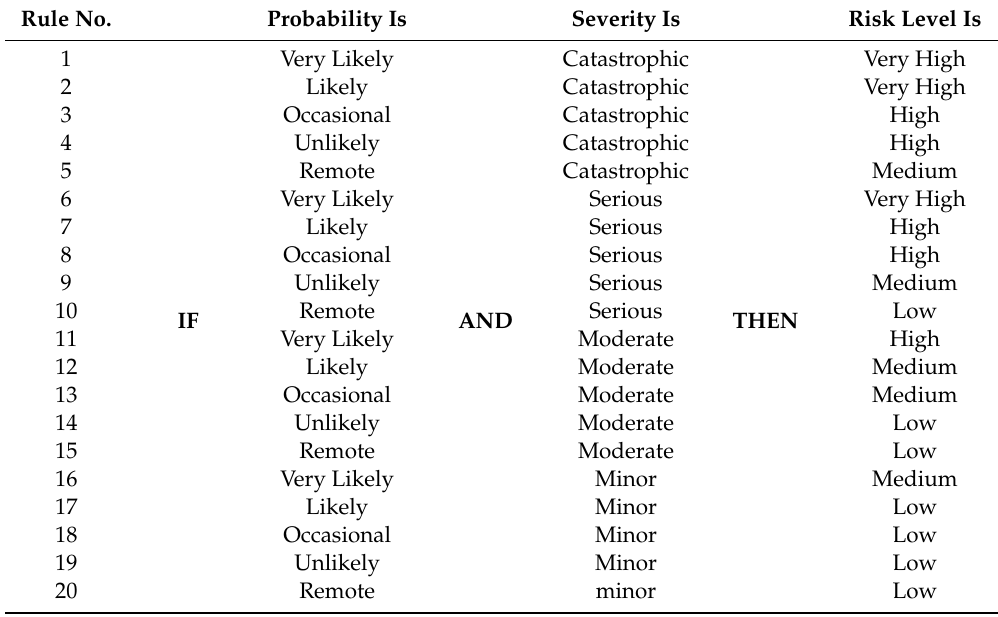
Table 5. FIS rules defined according to the risk assessment